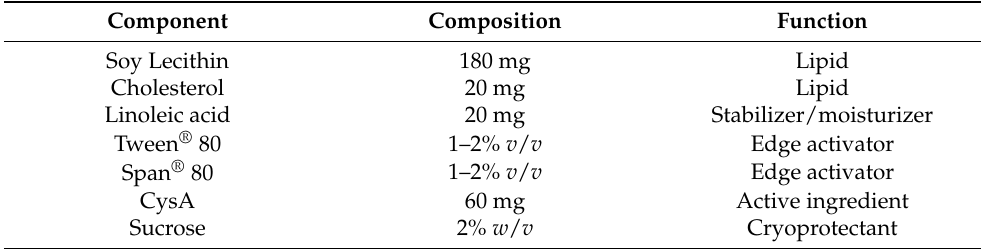
Table 1. Composition of transferosomes.